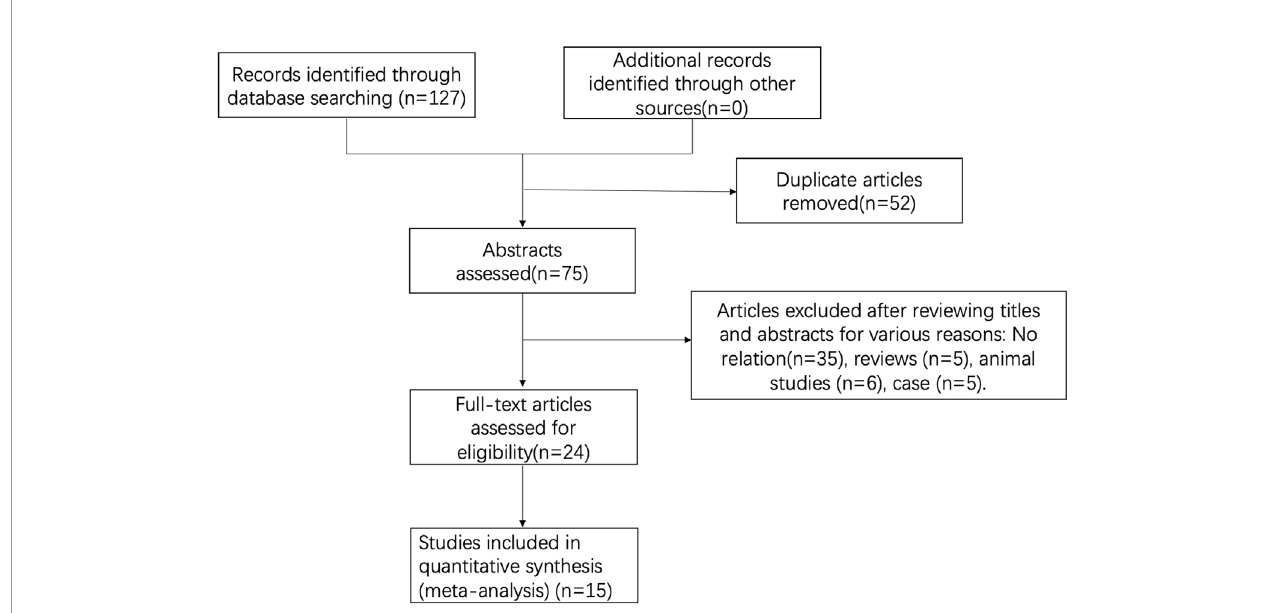
FIGURE 1 | Flow diagram of the literature search and study selection